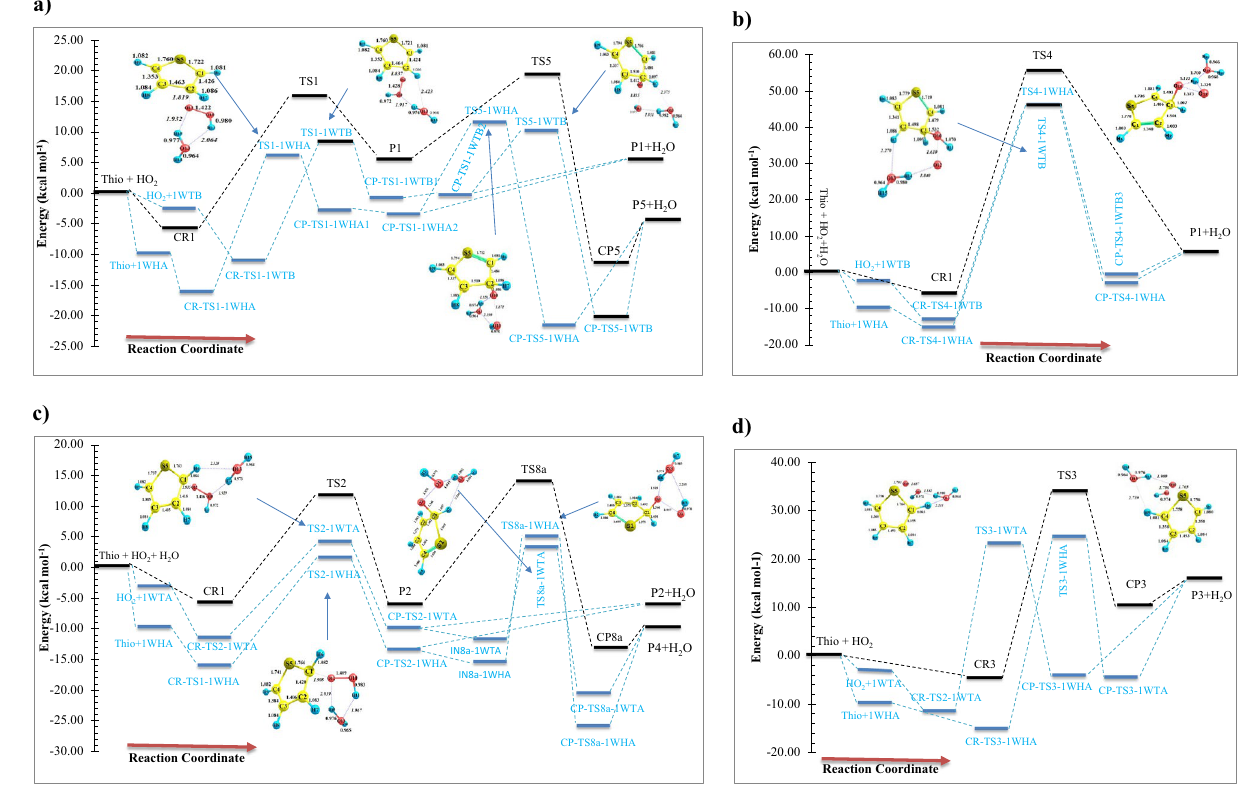
Figure 3. The energy profiles (at the BD(T) method) of the addition pathways in the thiophene + HO 2 reaction (the bare paths are shown by black dash lines, and the water-assisted paths are drawn by blue dash lines). ( a ) The terminal oxygen addition to β-C (first step) and the epoxy formation (second step). ( b ) The middle oxygen addition to β-C. ( c ) The terminal oxygen addition to α-C (first step) and ring-opening (second step). ( d) The terminal oxygen addition to the sulfur atom.